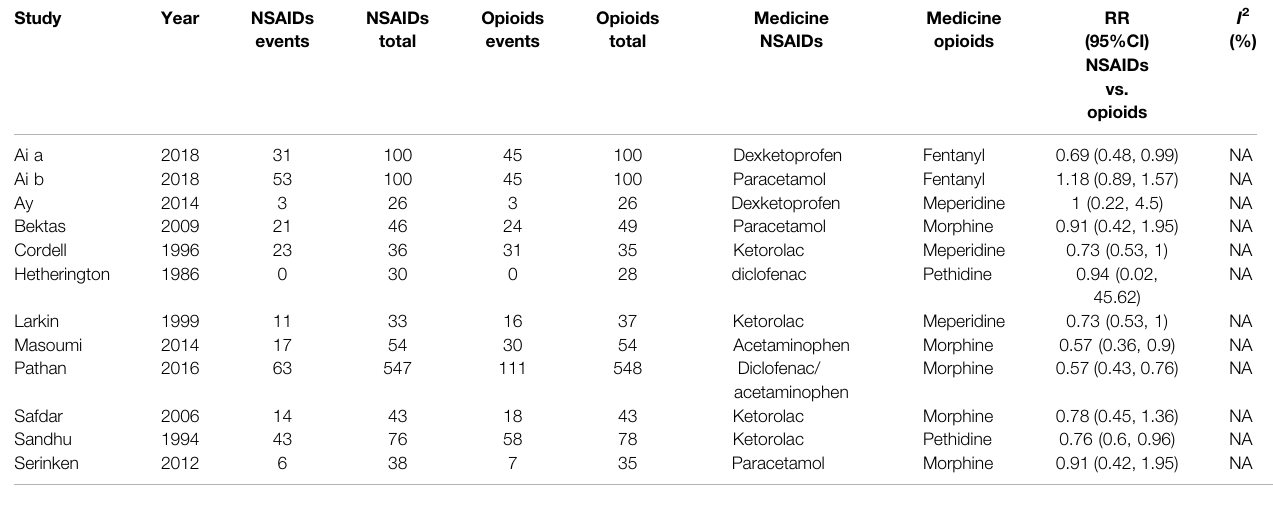
TABLE 5 | Subgroup analysis of NSAIDs and opioids of the needing for rescue analgesia.